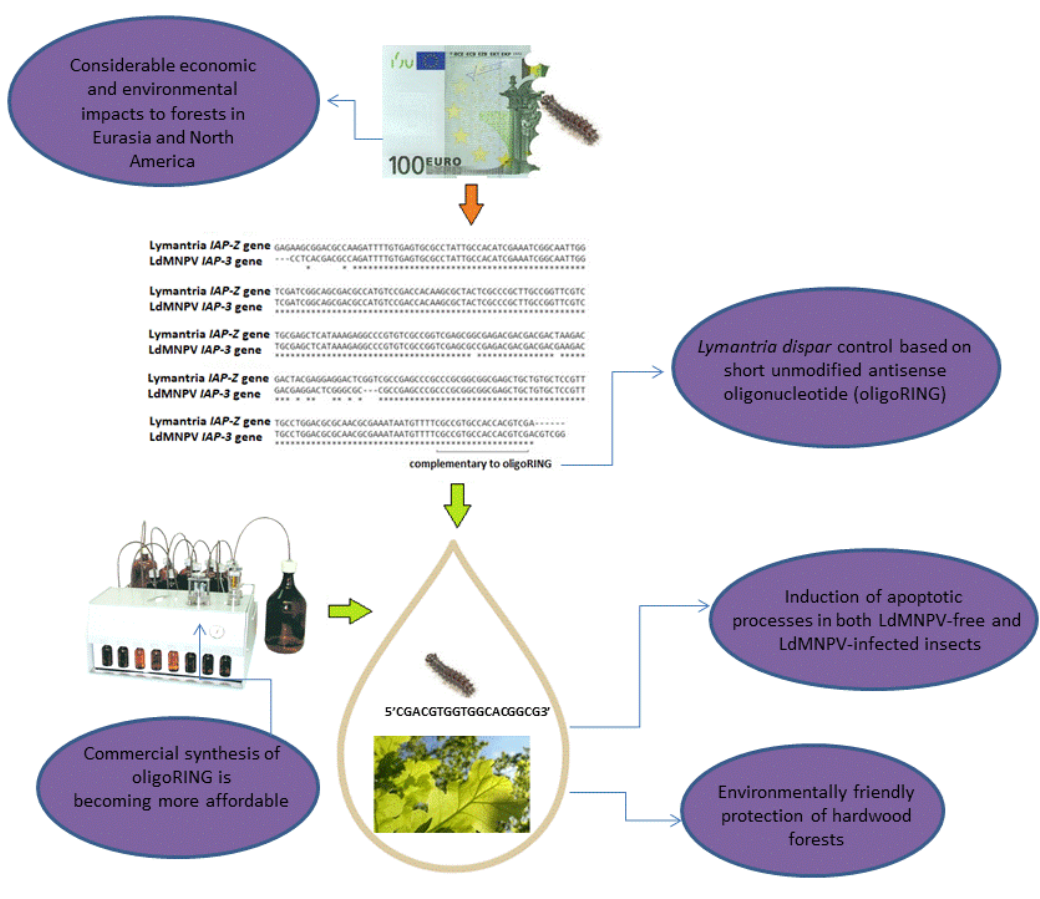
Figure 4. Perspectives of DNA insecticides for gypsy moth control.